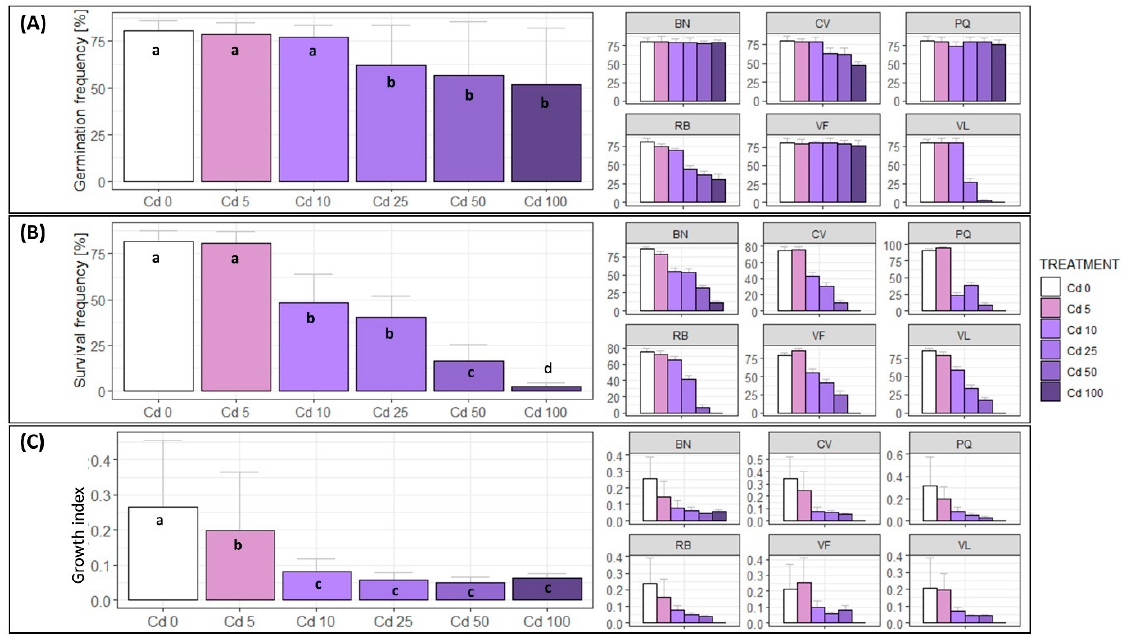
Figure 1. Influence of Cd on eggplant: ( A ) seed germination; ( B ) plantlet survival; ( C ) growth index. Data are shown together (left side) and independently (right side) for each investigated cultivar: BN = Bellezza Nera; CV = Cima Viola; PQ = Hybrid F1 Purple Queen; RB = Rotonda Bianca Sfumata di Rosa; VF = Violetta di Firenze; VL = Violetta Lunga. Error bars represent the standard deviation. Different letters indicate significant statistical differences ( p ≤ 0.05) among Cd treatments.